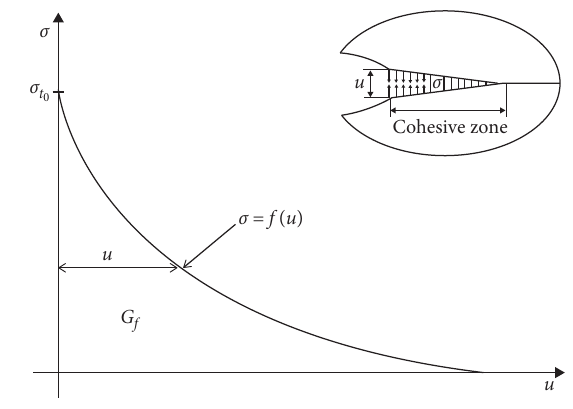
Figure 1: Fictitious crack model.